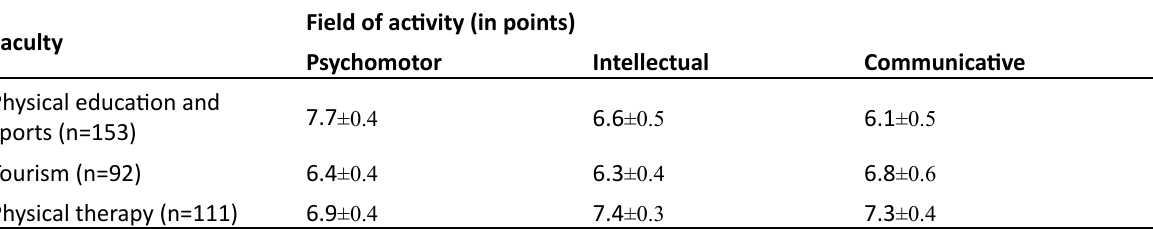
Table 2. Comparison of formal dynamic properties of students in different fields (in points, mean, standard deviation)